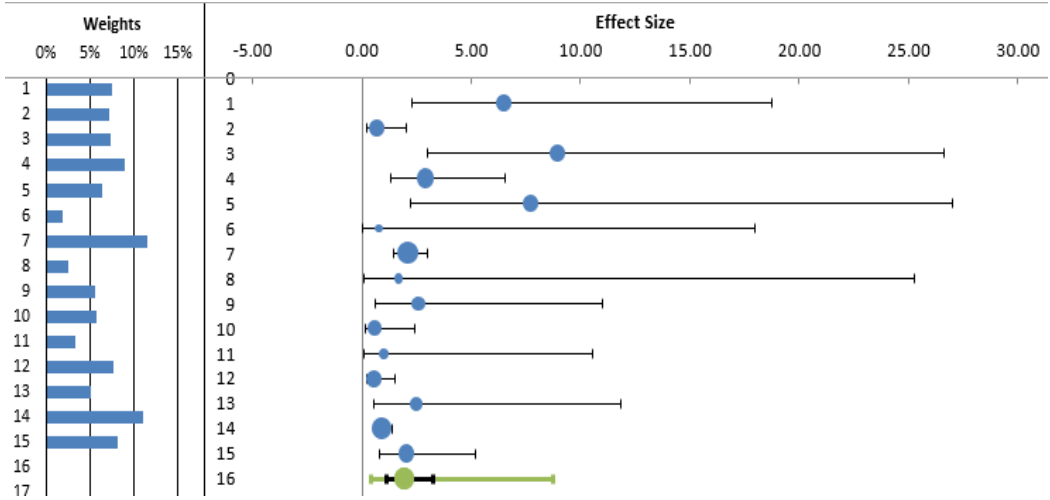
Figure 2. Forest plot of odds ratio for LD (diagnosed by antibodies) among exposed (outdoor) workers and other individuals not exposed (controls).